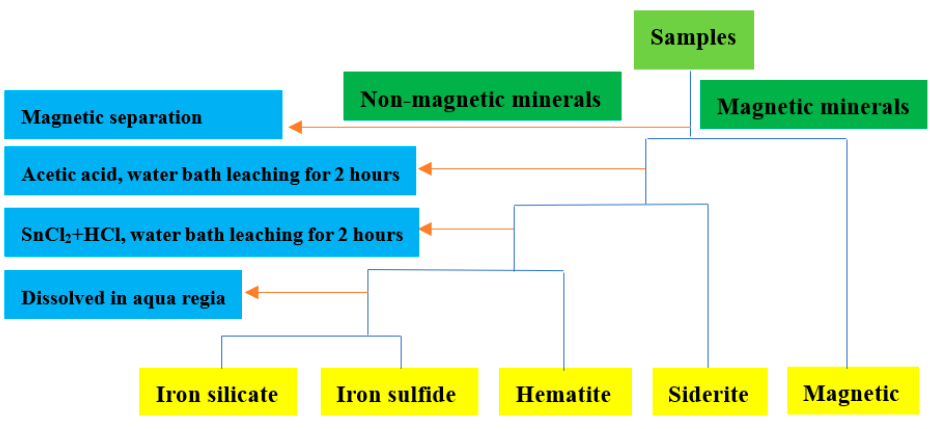
Figure 3. Iron phase analysis.